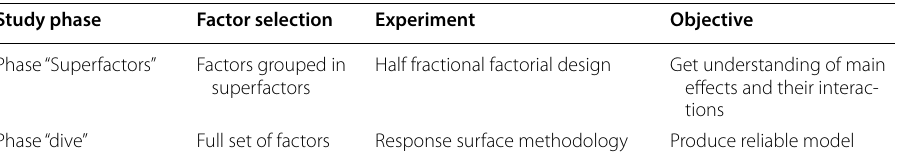
Table 2 Phases of the study Study phase